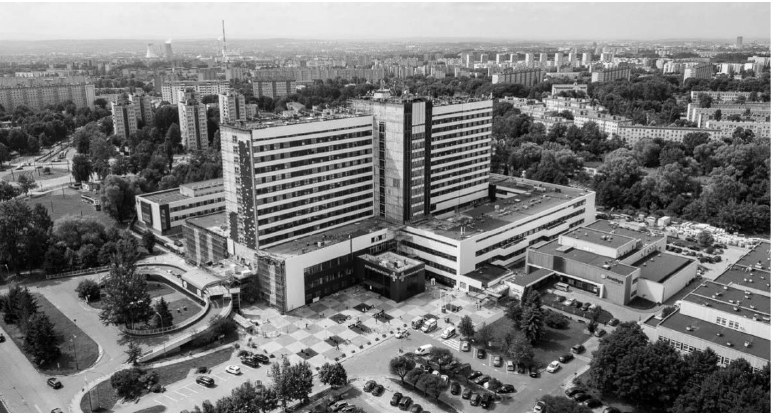
Figure 6. Tower-on-a-podium layout. ( a ) Planimetric scheme; ( b ) Axonometric scheme; ( c ) Axono- metric scheme with the minimum area that must be dedicated to the infectious disease section indi- cated red.